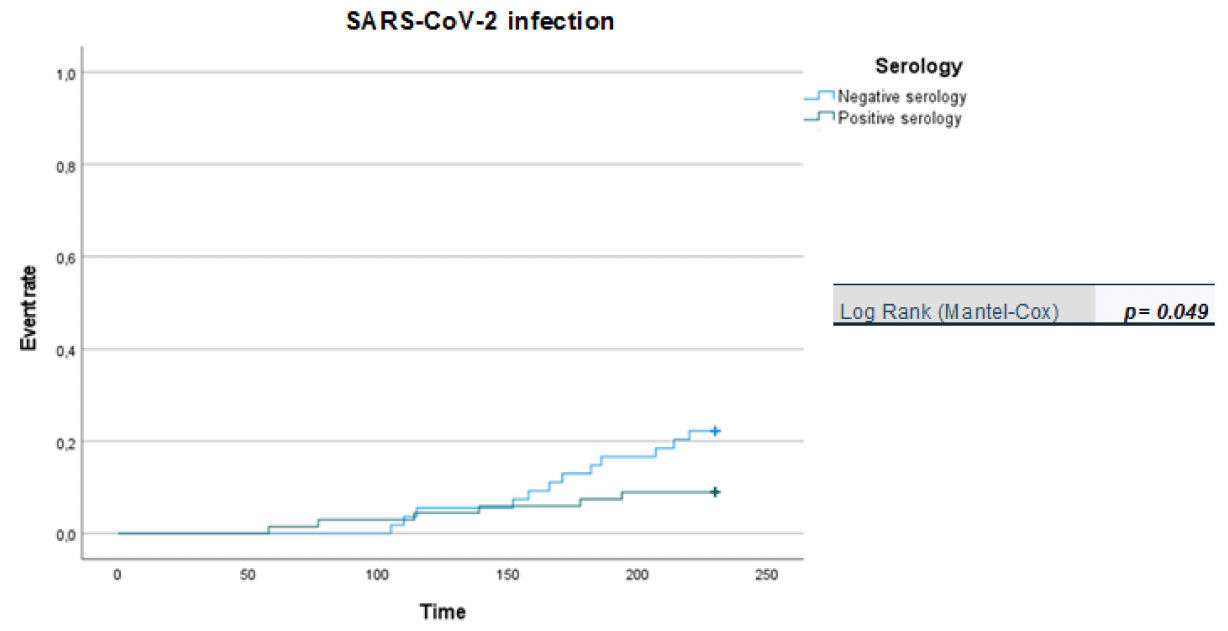
Figure 1. Kaplan-Meier curves: positive vs. negative serology in breakthrough infection (in